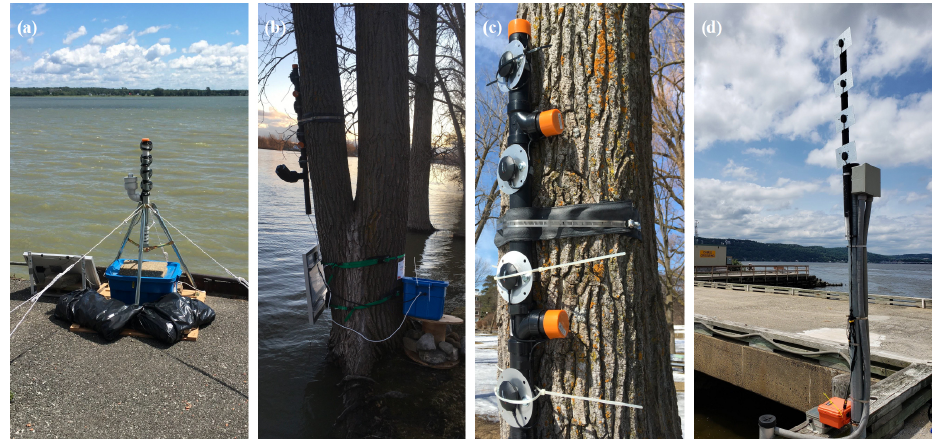
Figure 2. Pictures of antenna arrays (a) at Trois-Rivières, (b) and (c) show different angles at Sainte-Anne-de-Bellevue and (d) at Piermont. The antenna array shown in (b) and (c) was also temporarily installed at Trois-Rivières. The antennas are closer together in (a) in comparison to the other two setups. Table 1. Information about the three test sites. “SAB” refers to Saint-Anne-de-Bellevue. Antenna heights refer to mean heights above the water surface. Tidal Antenna Azimuth Elevation Length of Antenna Tide Distance from GNSS-R Location model angle limits angle